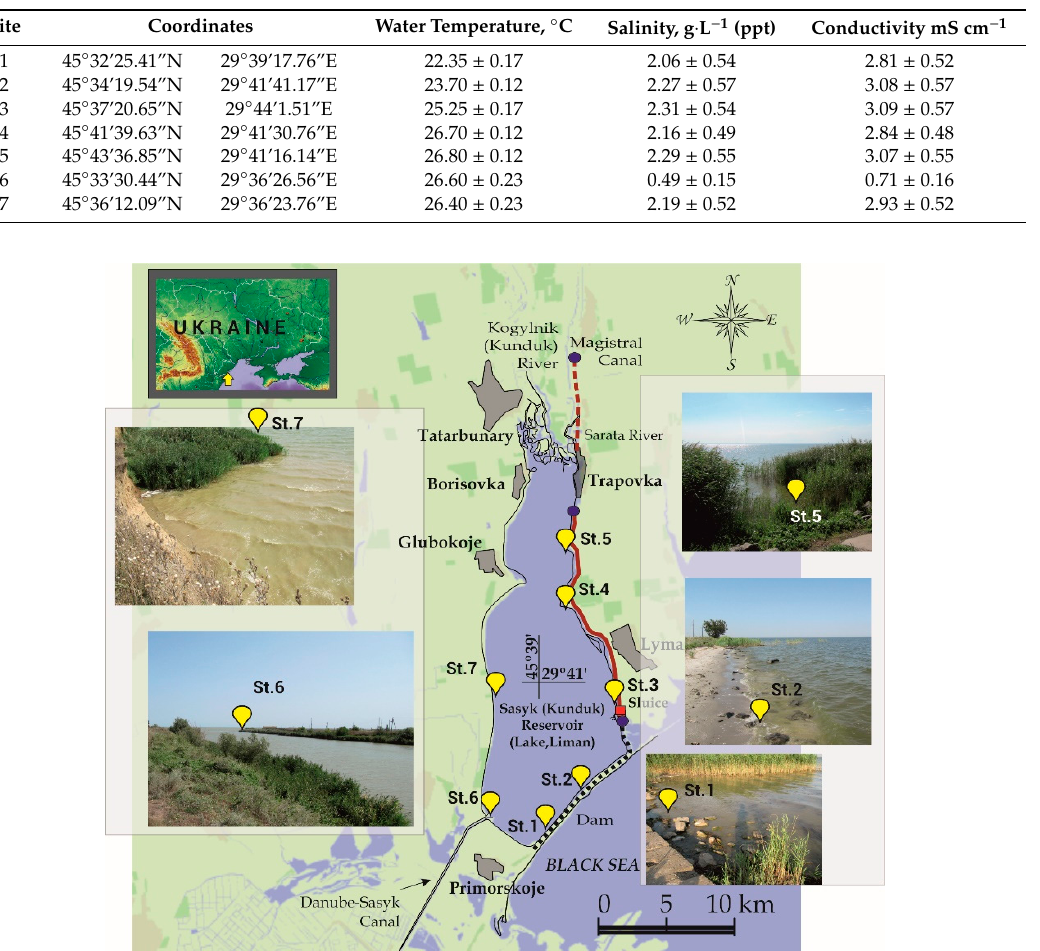
Figure 1. Diatom sampling locations at the Sasyk Reservoir during August 2018.